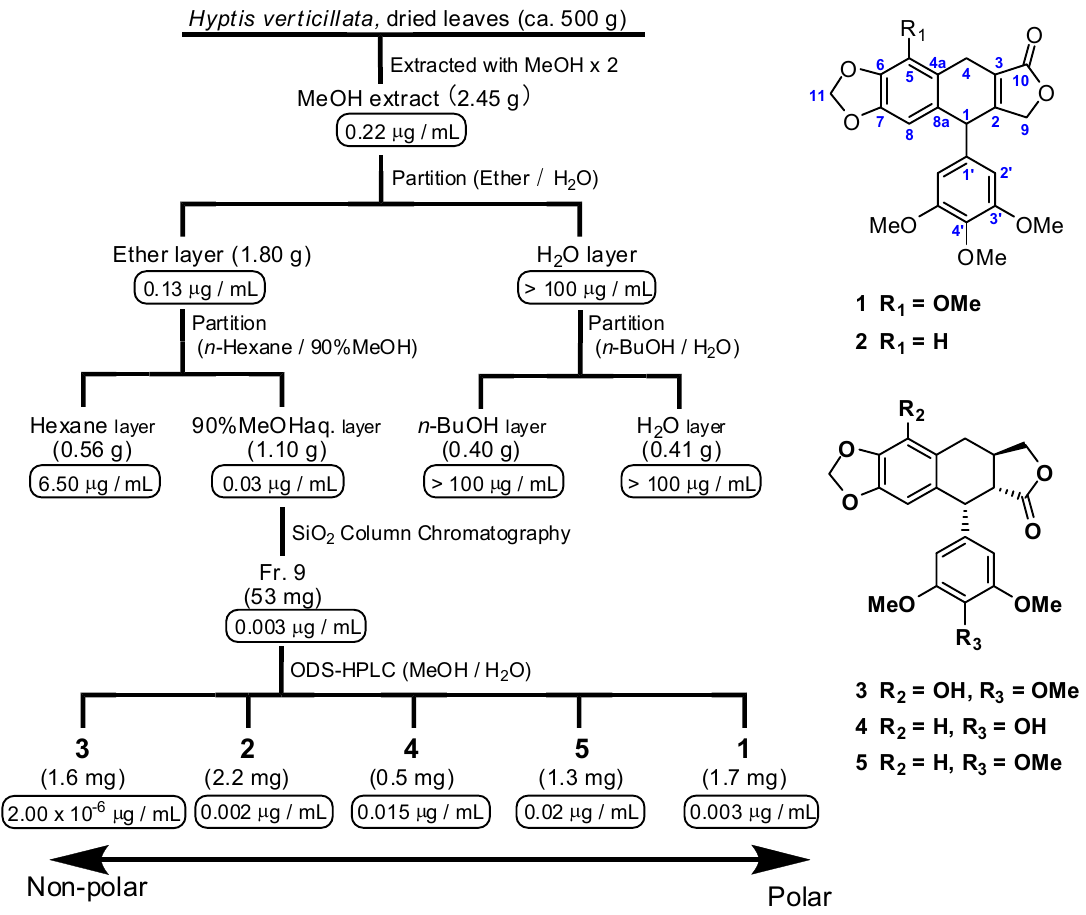
Figure 2. Bioassay-guided isolation scheme from dried leaves of Hyptis verticillata Jacq., and chemical structures of isolated, bioactive compounds. IC S1T cell line is indicated below each of the respective extracts and